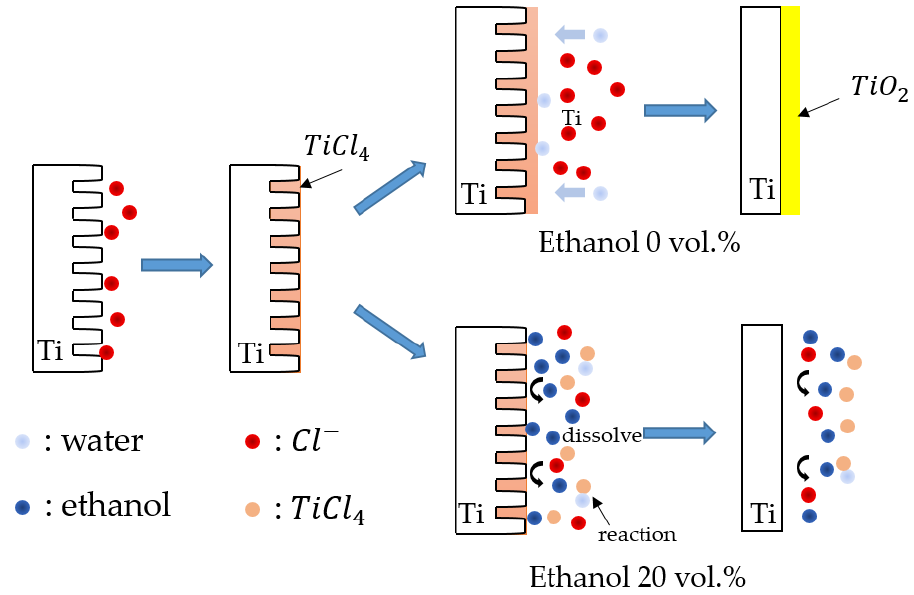
Figure 5. Illustration of the electropolishing mechanism of titanium according to the ethanol con- tration in electrolyte centration in electrolyte solution.